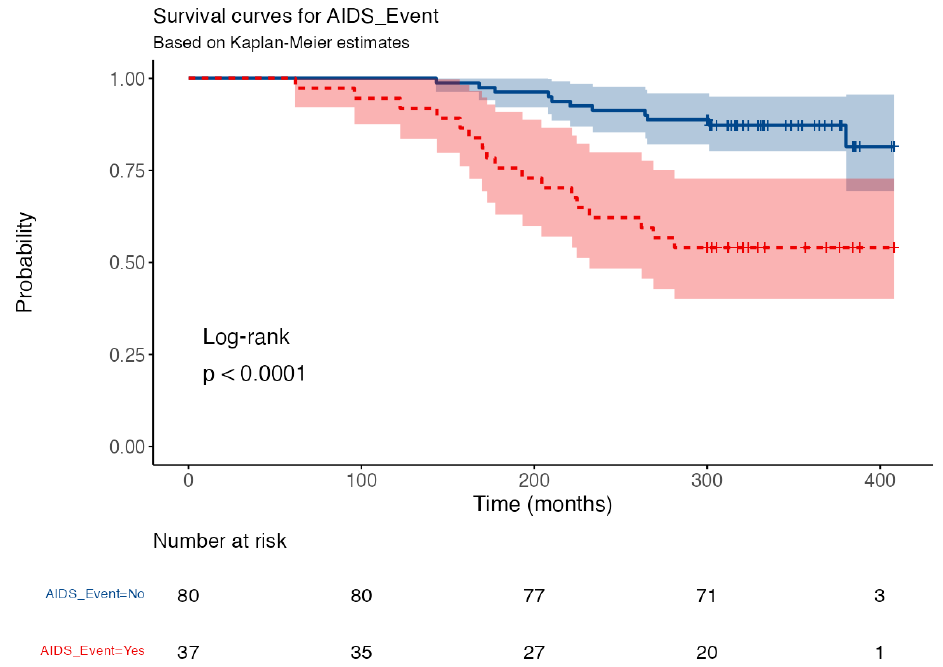
Figure 8. AIDS-related events influence the survival rate in PLWH who had access to HAART . This figure shows that in PLWH who were taking HAART, the appearance of an AIDS-related event is a negative prognostic factor for survival. Hazard ratio of those who had an AIDS-related disease was 4.329 (95% CI 1.866–10.040) compared with those who did not have an AIDS-related event, meaning